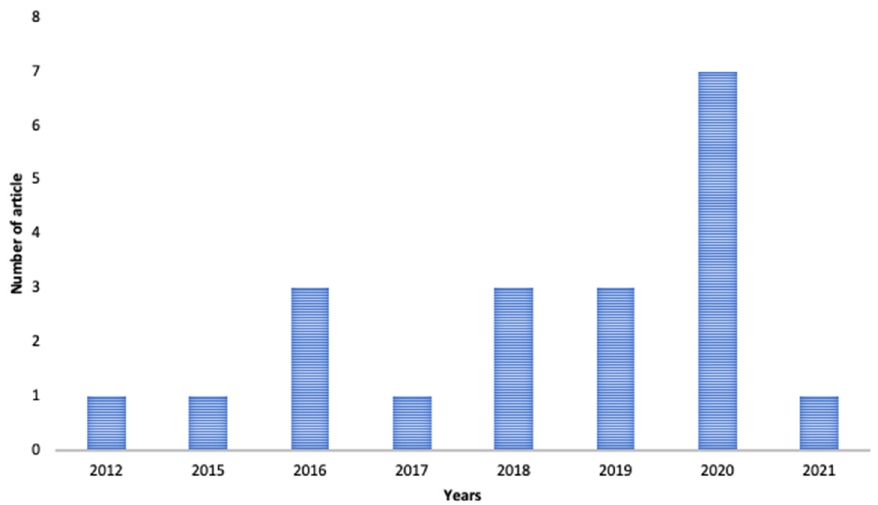
Figure 2. Distribution of articles based on the year of publication nanoformulation of α -mangostin for cancer.